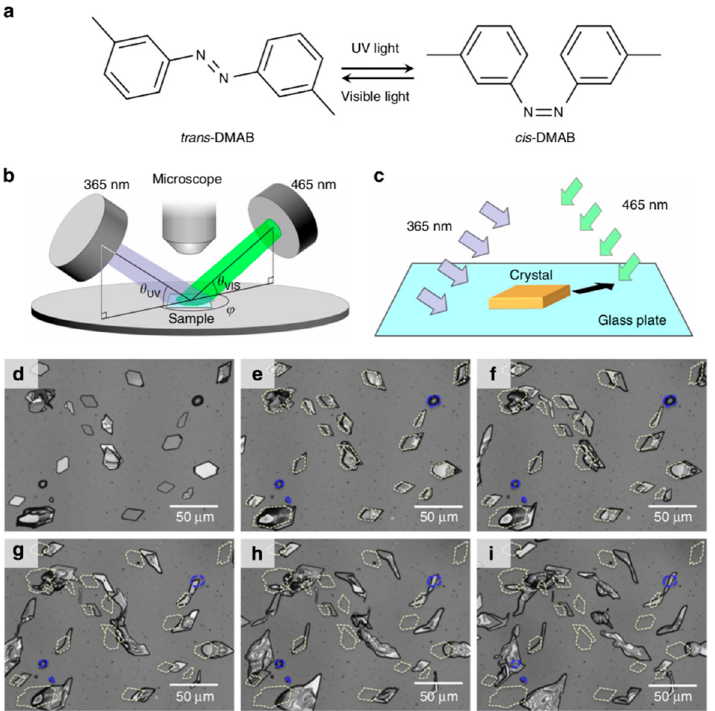
Figure 8. Light-induced crawling of crystals of 3,3 ′ -dimethylaminoazobenzne ( 26 ). Reprinted with permission from [46]. Copyright 2015 Springer Nature.